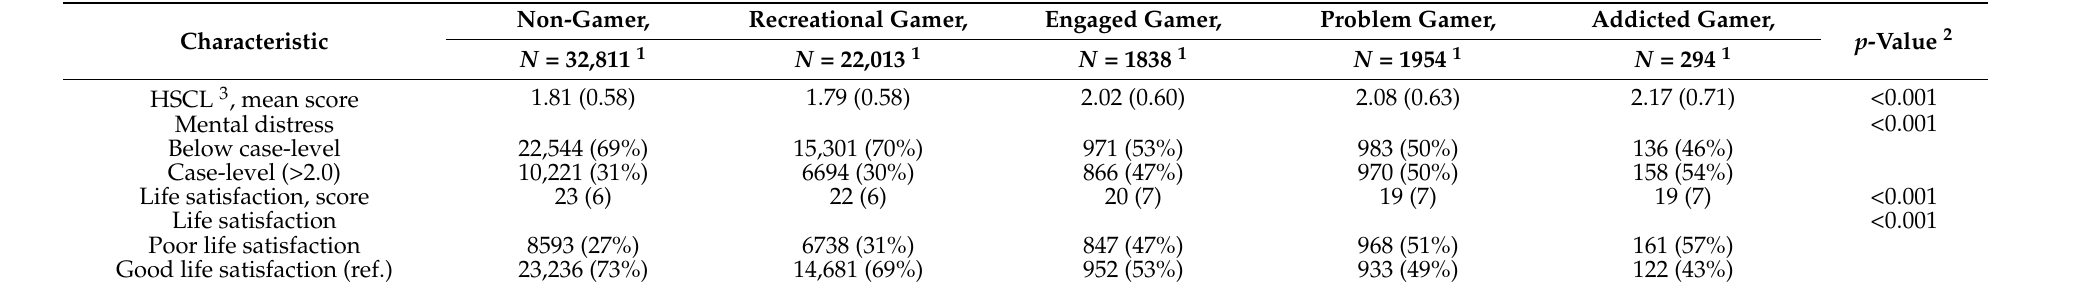
Table 2. Descriptive statistics for mental distress and life satisfaction across gaming